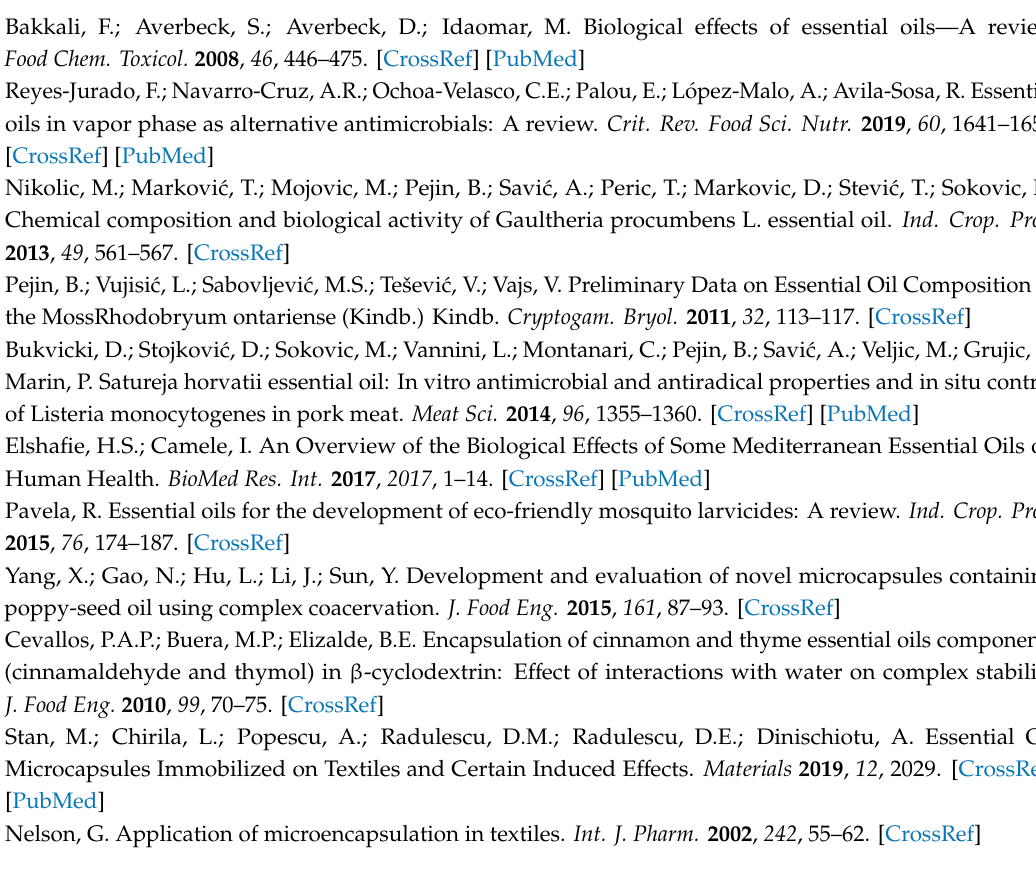
Figure S1: Response surfaces (a,c,e) and contour plots (b,d,f) for the e ff ects of LO mass, encapsulating time and encapsulating temperature on the encapsulation e ffi ciency (EE). Table S1: The experimental design and results for response surface